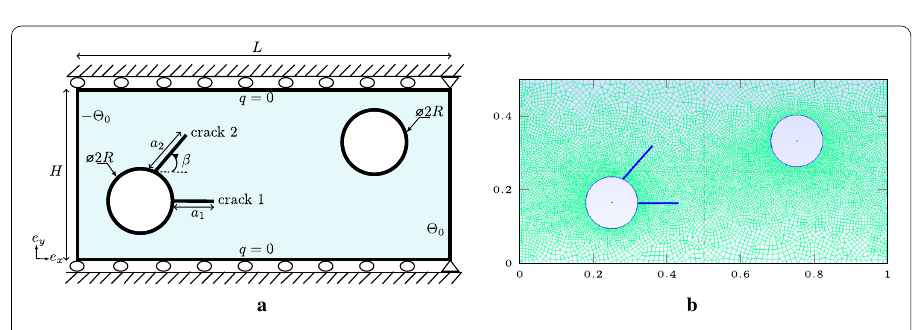
Fig. 23 Plate with two circular holes and multiple cracks: a geometry and boundary conditions for crack growth, b computational mesh used